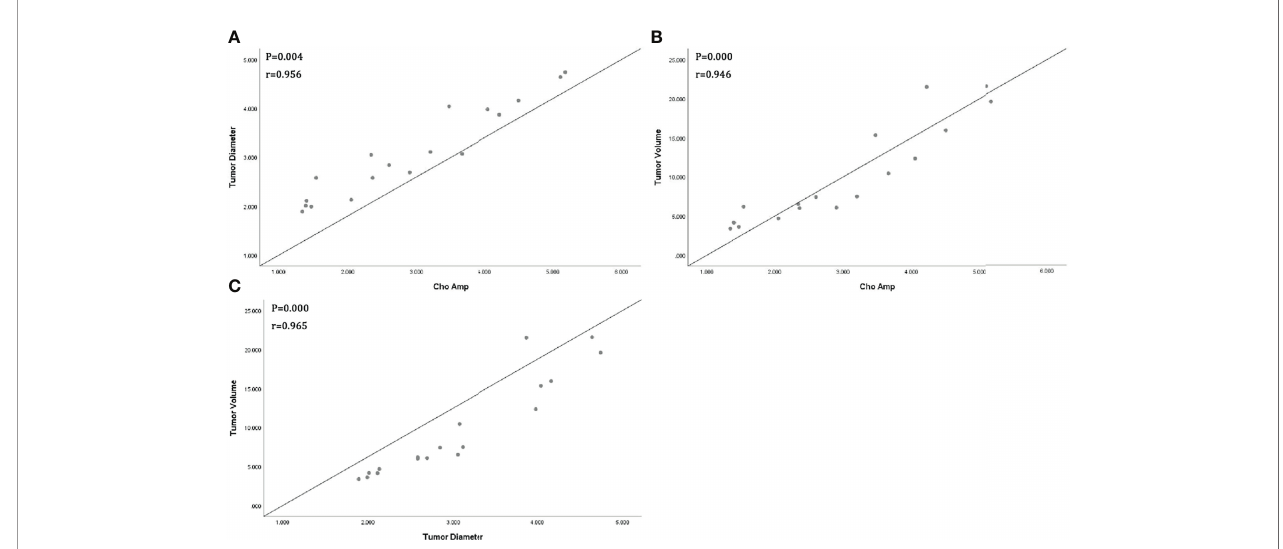
FIGURE 3 | Scatter plot represents positive correlations between Choline (Cho) peak amplitude and tumor diameter (A) , tumor volume (B) , and positive correlation between tumor diameter and tumor volume (C) .